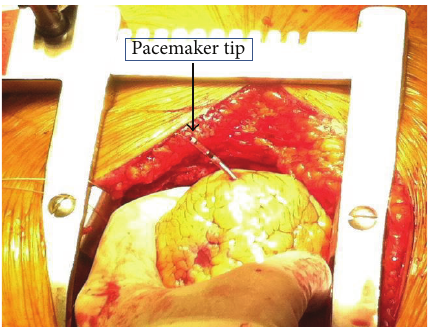
Figure 4: The tip of pacemaker lead is seen protruding out of the right